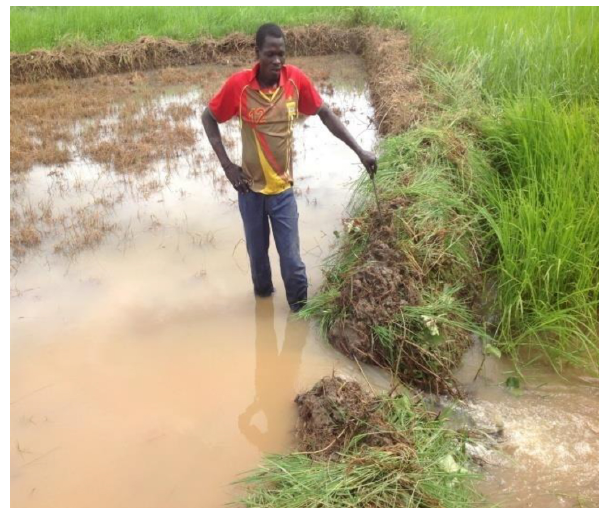
Figure 6. Photo 3 : Différentes formes de mise en valeur des bas- fonds dans le bassin Béninois de la Pendjari. Prise de vue : P. Ouassa, Août et Septembre